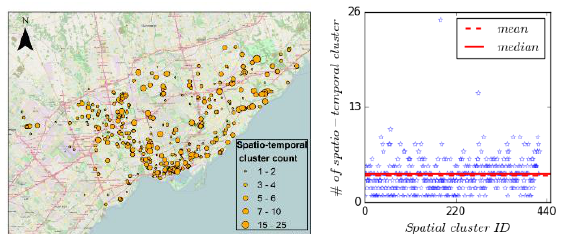
Figure 3. (a) Mapped spatiotemporal clusters, the size of circle refers to the number of spatiotemporal clusters associated to a spot. Big circles may contain different types of activity, while the circles with the same size at different locations may be caused by the same type of activities. (b) The density of spatiotemporal clusters in each spatial